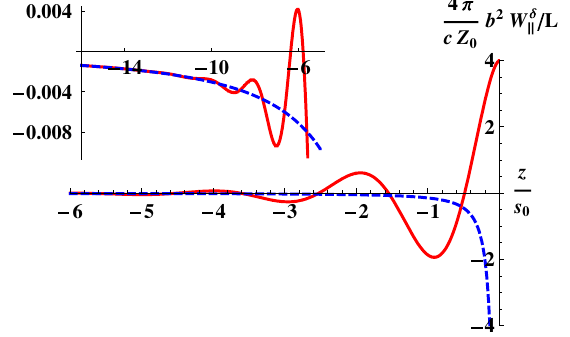
FIG. 3. (Color) Longitudinal wake function given by Eq. (44) (solid) and long-range approximation from Eq. (23) (dashed).